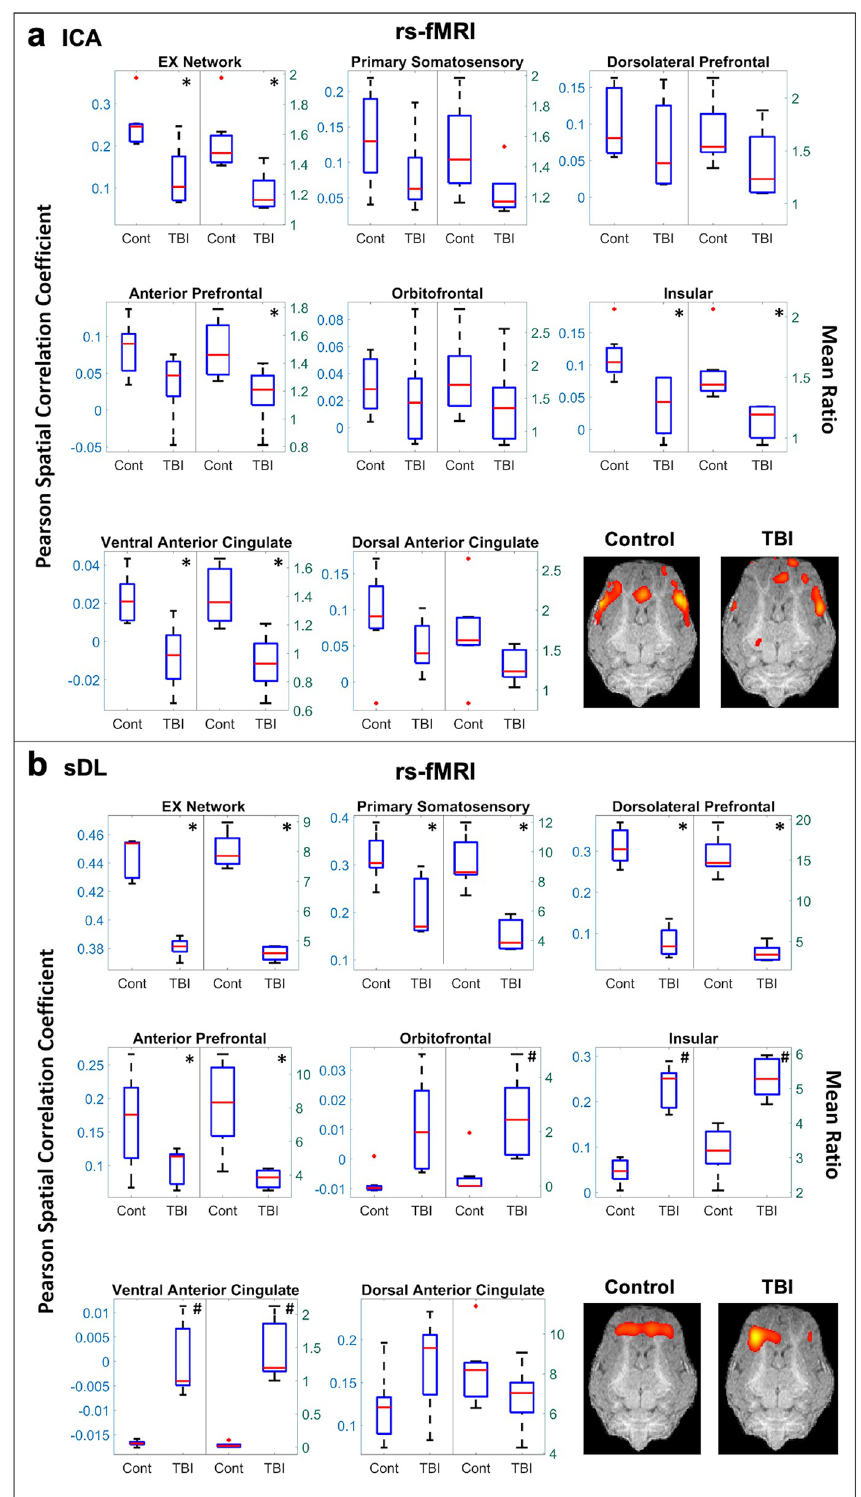
Figure 1. Resting-state (rs-) analysis of the executive control (EX) network. Boxplots of Pearson spatial correlation coefficients (left) and mean ratios (right) obtained from the rs- analysis for the EX network and its individual anatomical regions obtained using independent component analysis (ICA; a ) and sparse dictionary learning (sDL; b ). The red line denotes the median, the blue box denotes the interquartile range, and the lower and upper whiskers denote the min and max, respectively. An asterisk (*) or pound (#) in the upper right-hand corner indicates significant decrease or increase (p < 0.05), respectively, for the TBI group in comparison to the control group. Representative coronal plane activation maps overlaid on the template pigs’ T1-weighted anatomical image are also displayed. Representative maps in the axial and sagittal plane are provided in the Figures S4 and